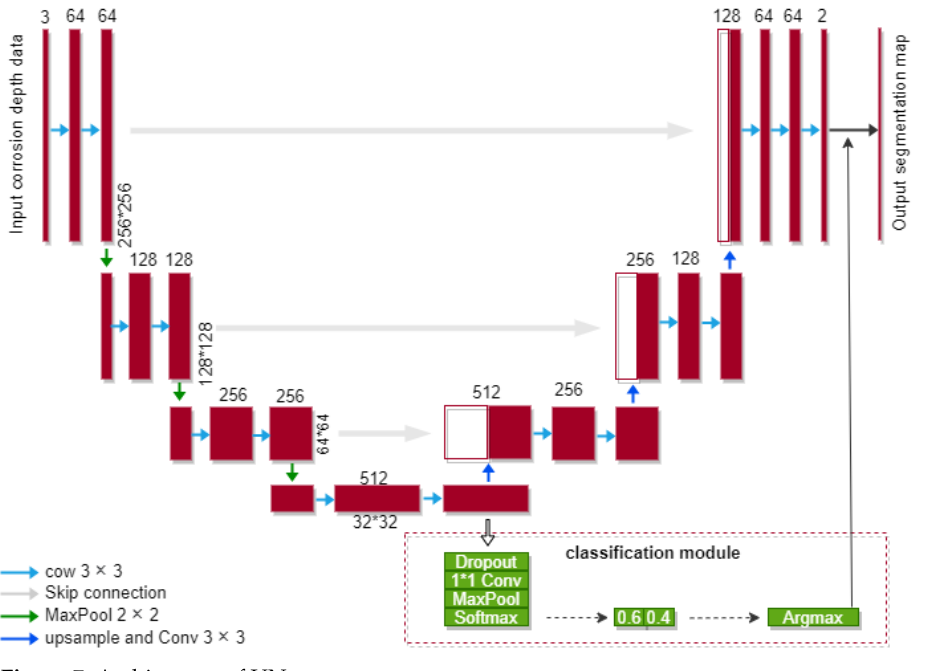
Figure 7. Architecture of UNet.